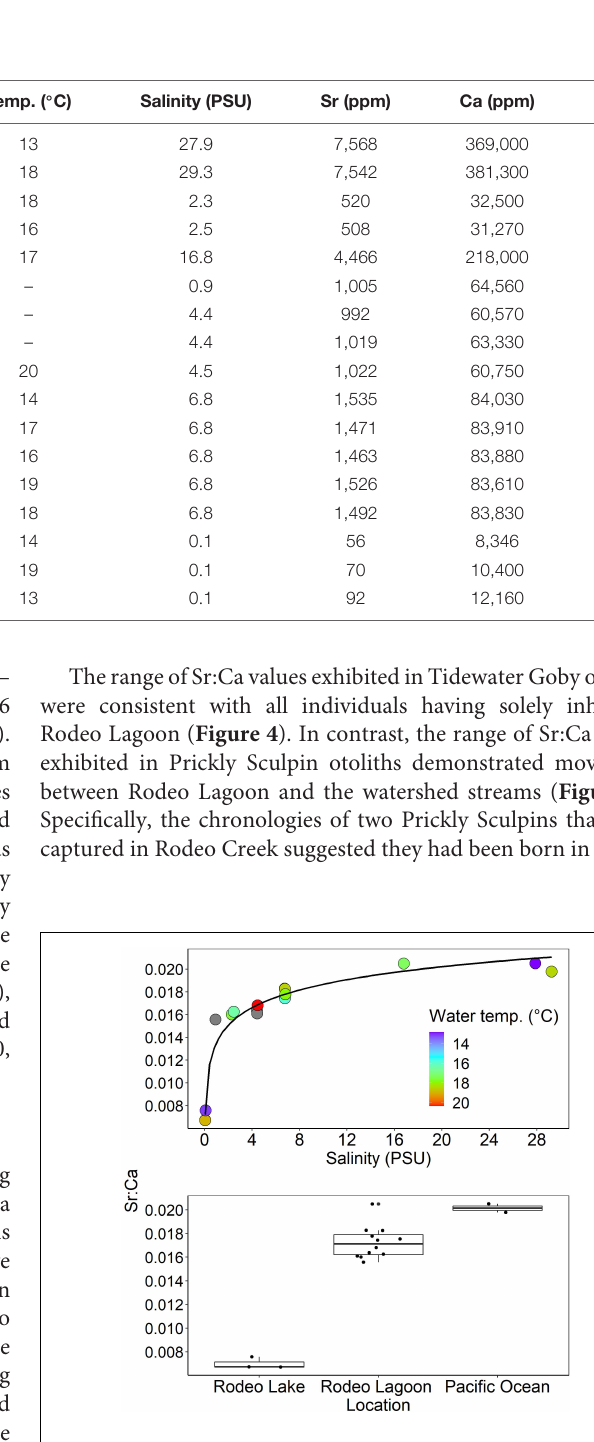
FIGURE 3 | Upper: Relation between salinity and Sr:Ca in the Rodeo Lagoon system. The line is an exponential curve fitted to the data. Water temperature values were measured at the time of water sample collection; dark gray points do not have corresponding temperature data. Lower: Boxplot representation of the same Sr:Ca data aggregated according to samples collected in Pacific Ocean, Rodeo Lagoon, and Rodeo Lake. Jitter was imposed on the data points in the lower plot to avoid superimposition. Box plot shows the median, 25th and 75th percentile and upper and lower values of 1.5* (inter quartile